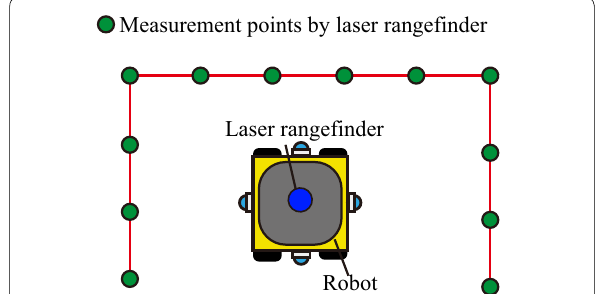
Fig. 4 Estimating the 3D models of the walls (Top-view). The yellow rectangle, the blue circle, and the green circles represent the robot, the LRF, and the measurement points by the LRF, respectively. The red lines connecting the green circles represent the 3D models of the wall